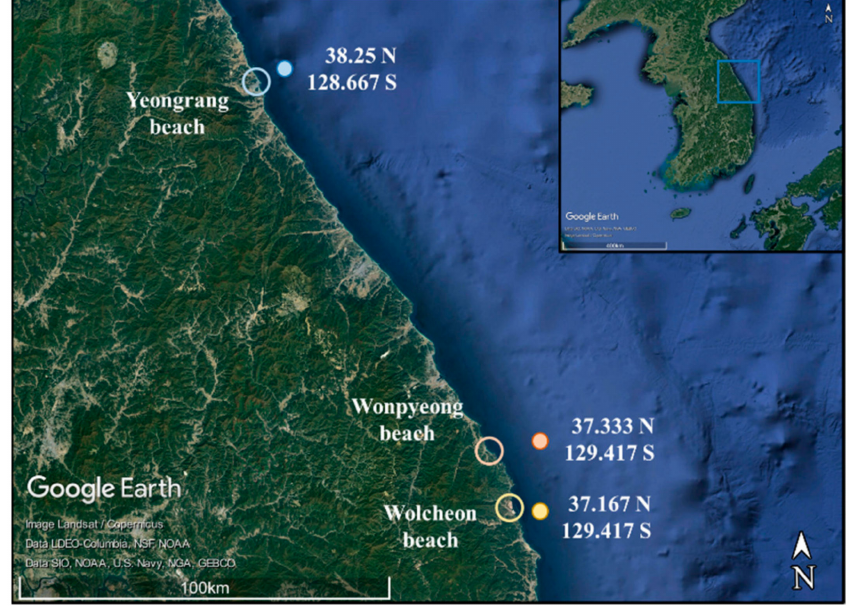
Figure 9. Location of studied sites and hindcast wave data.